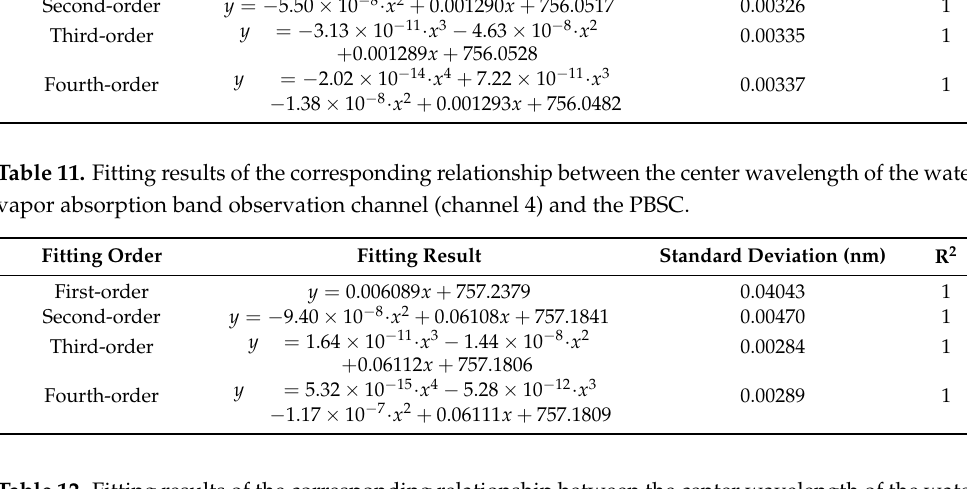
Table 12. Fitting results of the corresponding relationship between the center wavelength of the water vapor absorption band observation channel (channel 5) and the